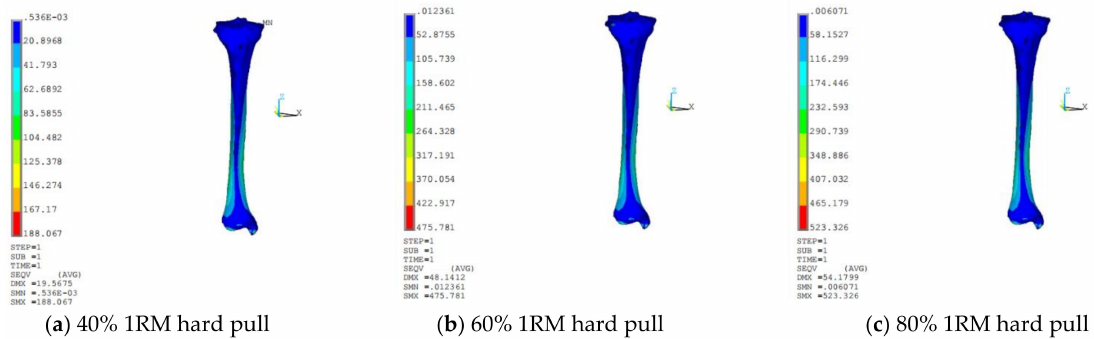
Figure 11. Cloud chart of tibia stress distribution of hard